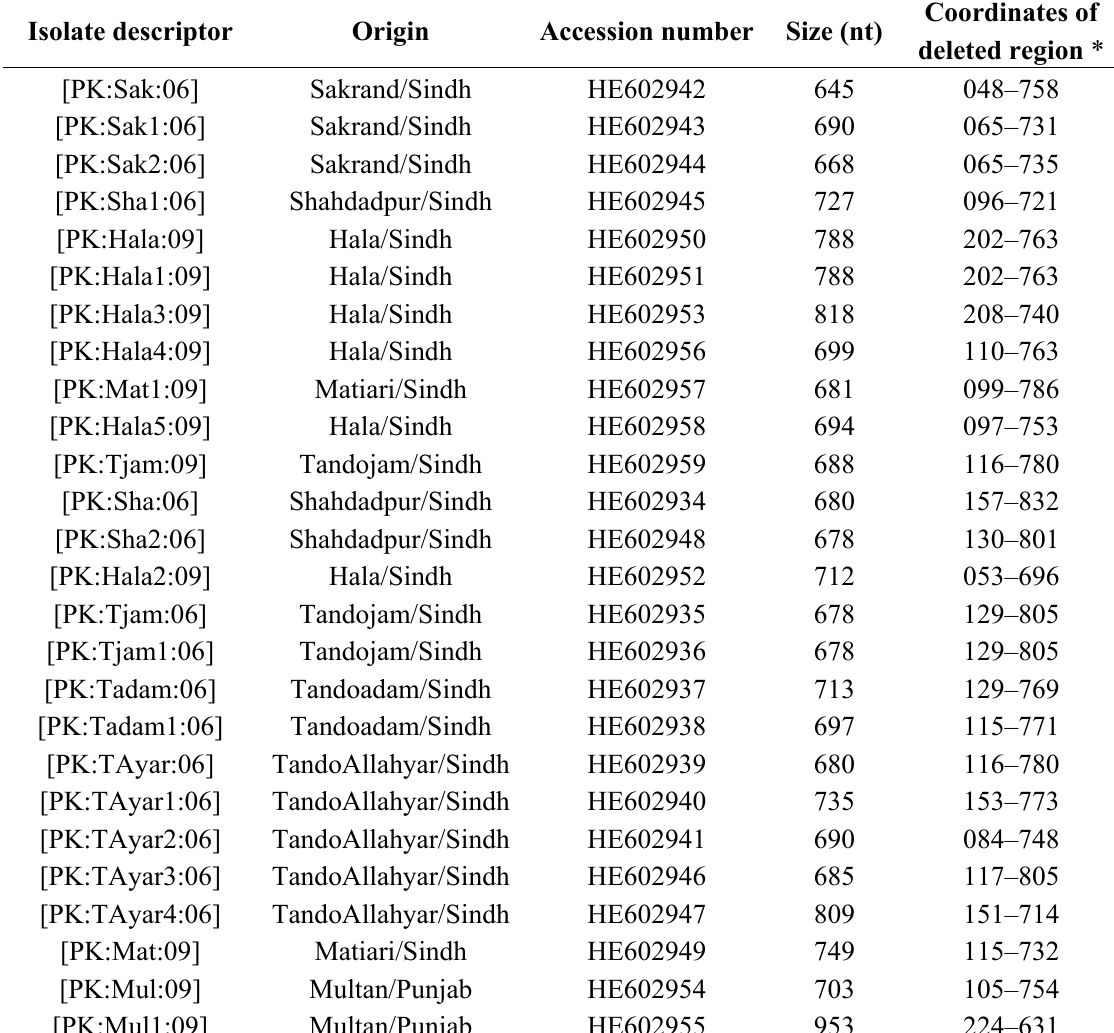
Table 2. Origins and features of defective